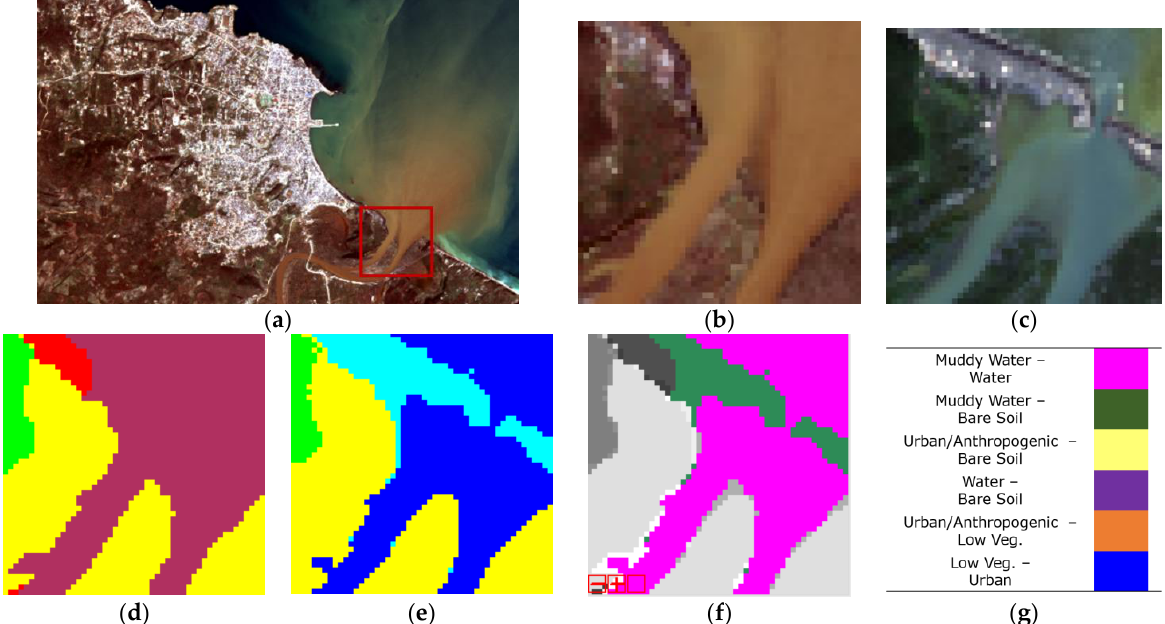
Figure 12. Details of the mouth of the Grande Anse River: ( a ) RGB composition of the optical image acquired in 2016 with the indication of the considered crop; ( b ) RGB composition of the optical crop acquired in 2016; ( c ) RGB composition of the optical crop acquired in 2017 (image © CNES 2016–2017, distribution Airbus DS); ( d ) classification map corresponding to the crop of 2016; ( e ) classification map corresponding to the crop of 2017; ( f ) change map corresponding to the timeframe 2016–2017; ( g ) legend of the change map. The legend of the classification maps is given in Table 1.